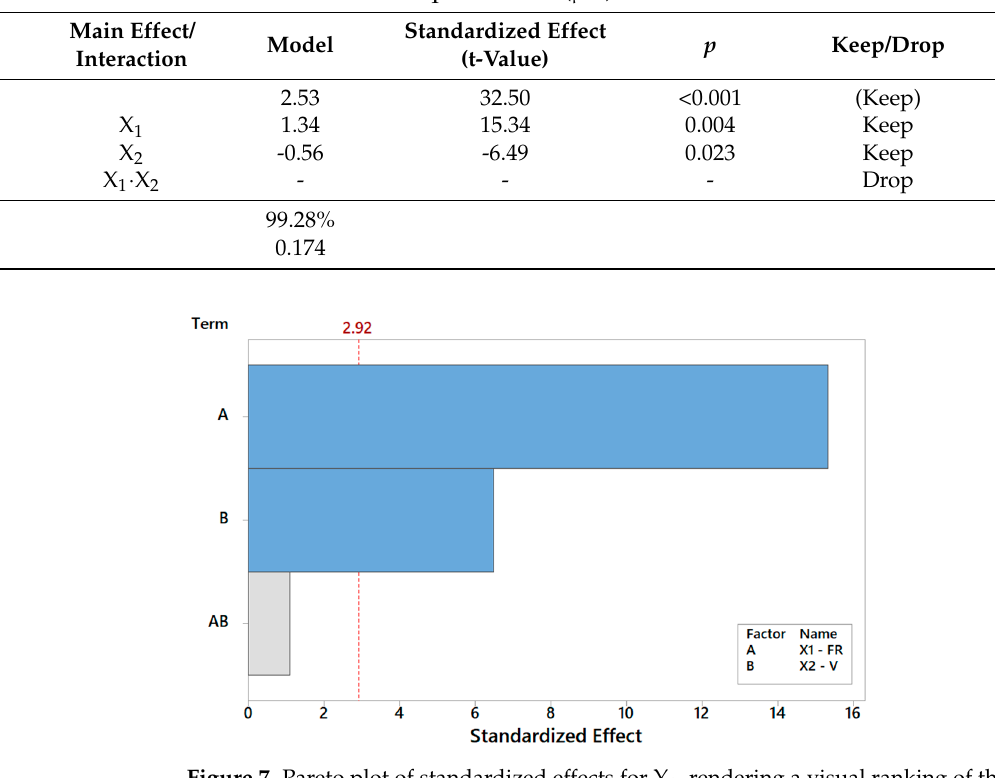
Figure 7. Pareto plot of standardized effects for Y 1 , rendering a visual ranking of their role on the FD. A gray bar represents a term not in the model.